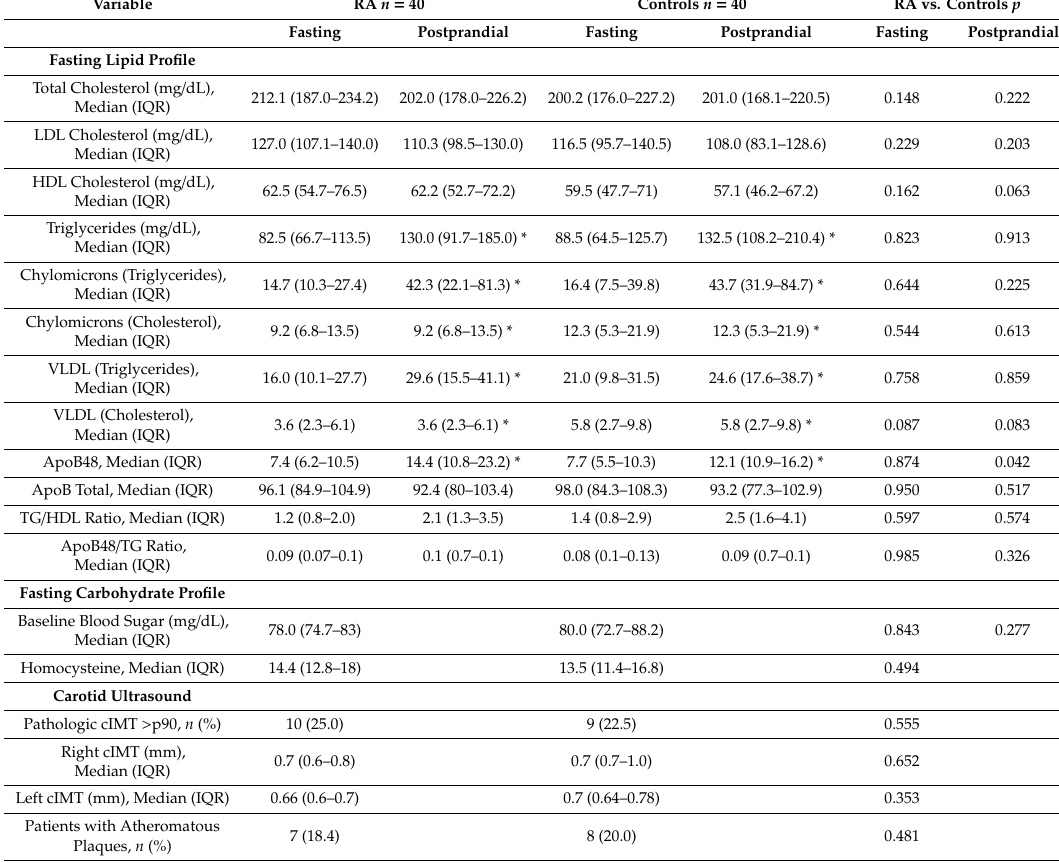
Table 2. Lipid profile and carotid ultrasound in 40 patients with RA and 40 controls. Variable RA vs. Controls p Fasting